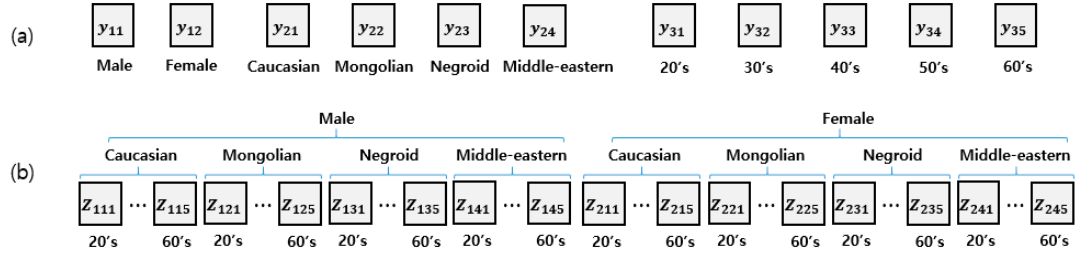
Figure 5. Output representation for three attribute recognition tasks (gender, race, and age): ( a ) Representation for independent tasks and ( b ) for correlated tasks.